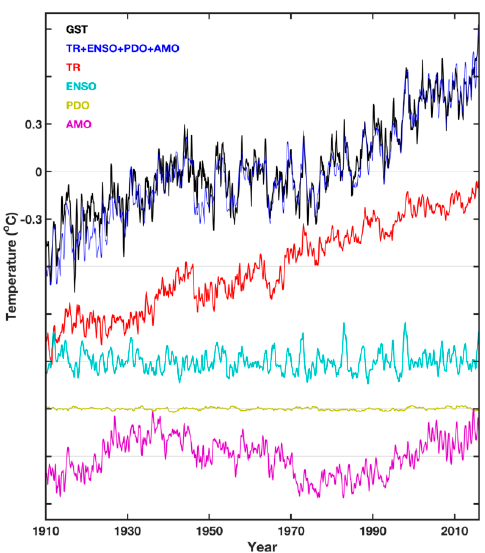
Figure 7. The composition of the IPO. IPO index in black. The composition of the IPO as reconstructed using the sum of its four leading components in blue. The individual component is also shown. It is dominated by the AMO. IPO is here defined as the second Principle Component of 13-year low-pass filtered SST. Reproduced from Chen and Tung [7].